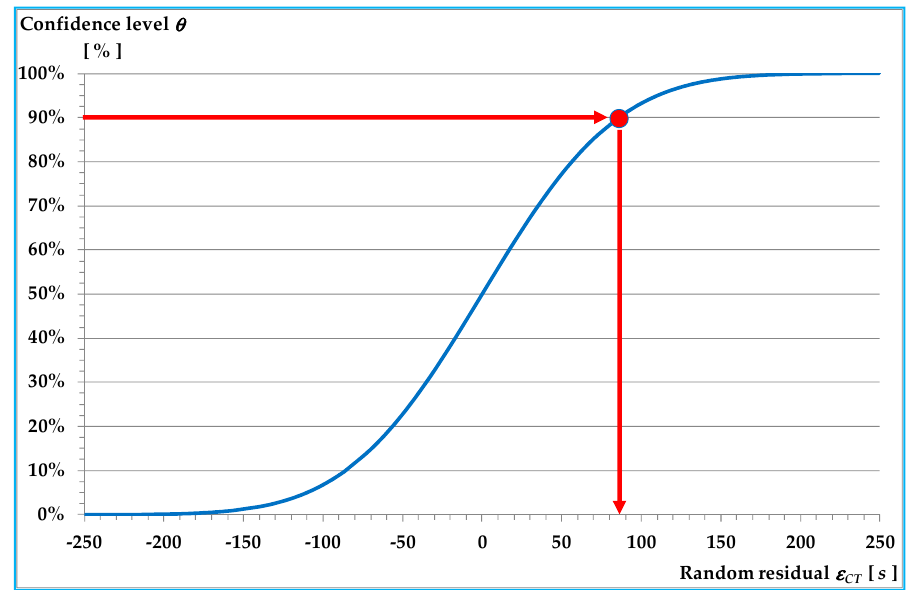
Figure 1. Cumulative distribution of Figure 1. Cumulative distribution of Ω CT ( · )